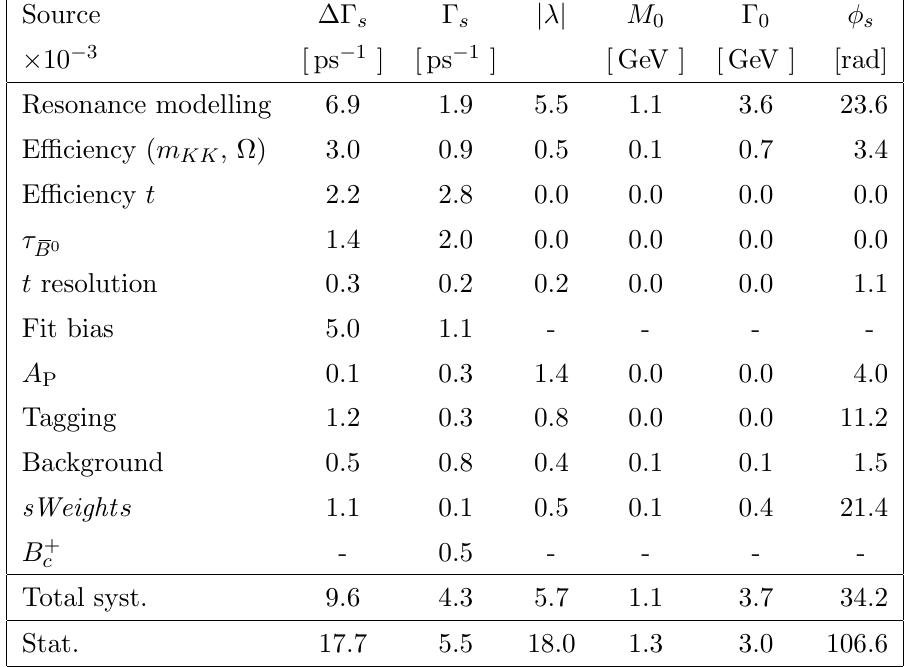
Table 5 . Absolute systematic uncertainties for the physics parameters determined from the high m KK region compared to the corresponding statistical uncertainty. Here M 0 and (cid:0) 0 refer to the uncertainties on the f 0 (1525) resonance mass and 2